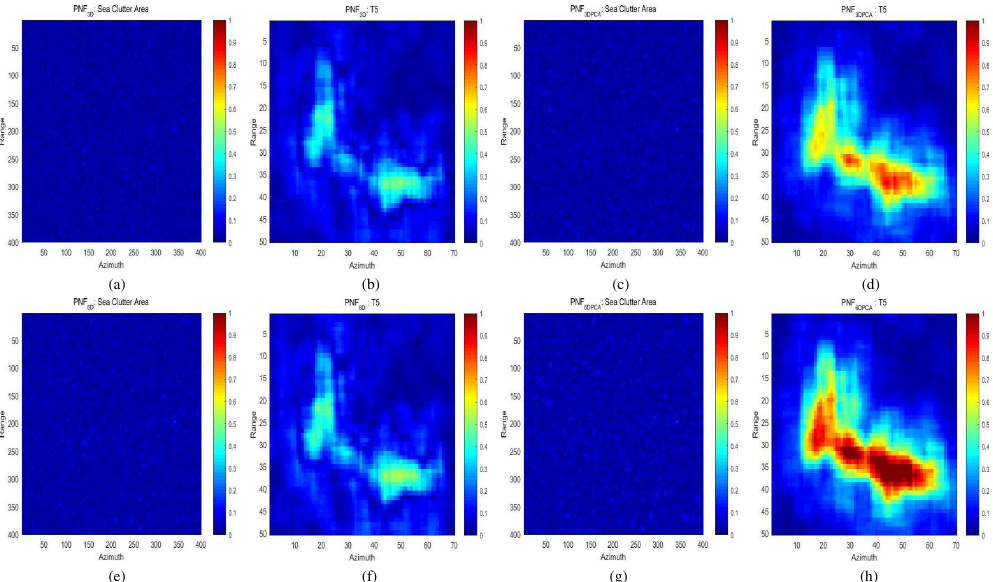
Figure 11. P T values of the sample sea area and T5. ( a ) PNF 3D : the values of sea clutter; ( b ) PNF 3D : the values of S1; ( c ) PNF 3DPCA : the values of sea clutter; ( d ) PNF 3DPCA : the values of S1; ( e ) PNF 6D : the values of sea clutter; ( f ) PNF 6D : the values of S1; ( g ) PNF 6DPCA : the values of sea clutter; ( h ) PNF 6DPCA : the values of S1. Note that the units of the colorbar are normalized. Table 4. TCR values of smaller ships and average TCR values of 24 ships of B (dB).